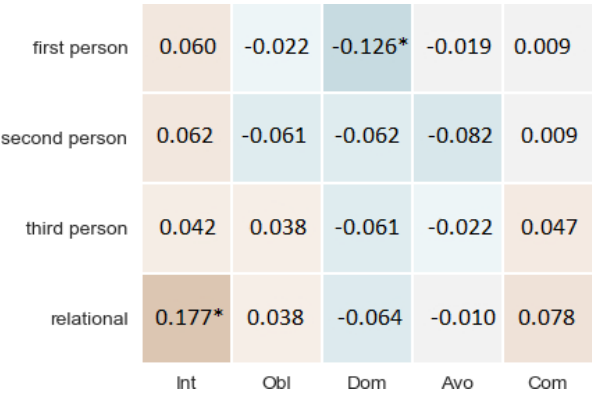
Figure 4. Correlation coefficients between the use of first person, second person, third person and relational pronouns on the y axis, and the ROCI-II scores of the user, placed on the x axis. (*) Significant values ( p < 0.05) are marked with asterisks.